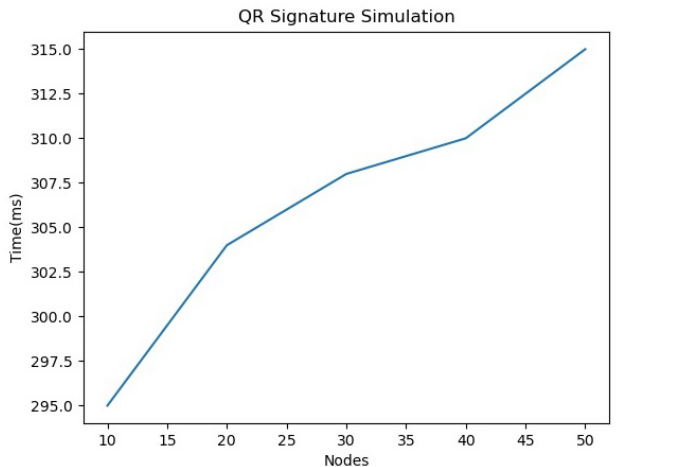
Figure 1. QR Signature Simulation on 10 nodes to 50